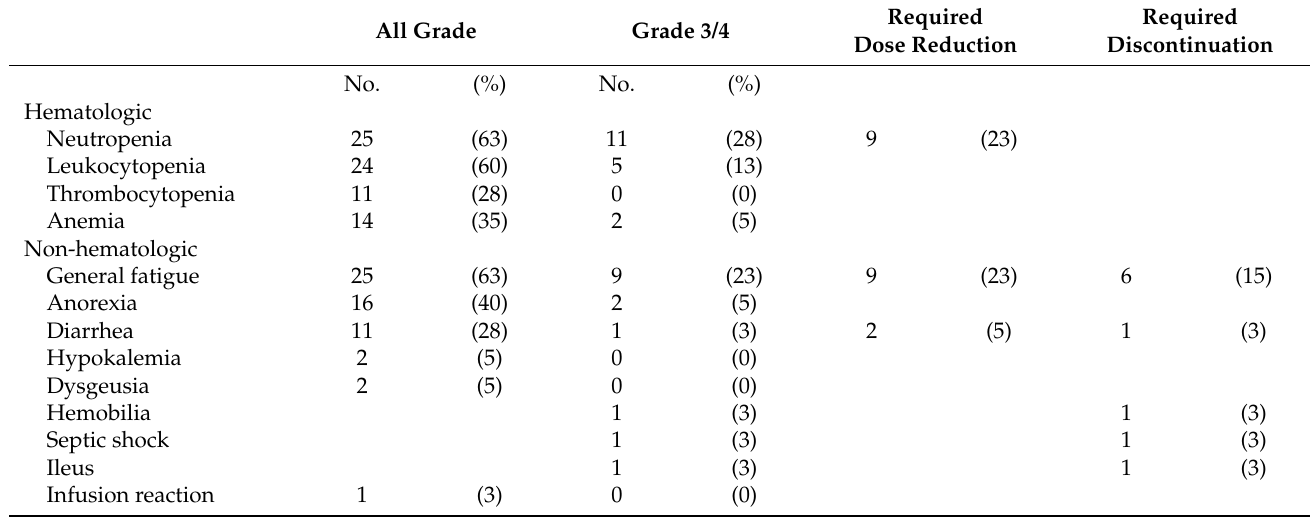
Table 4. Adverse events during irinotecan plus fluorouracil/folinic acid (nal-IRI/FF) treatment. All Grade Grade 3/4